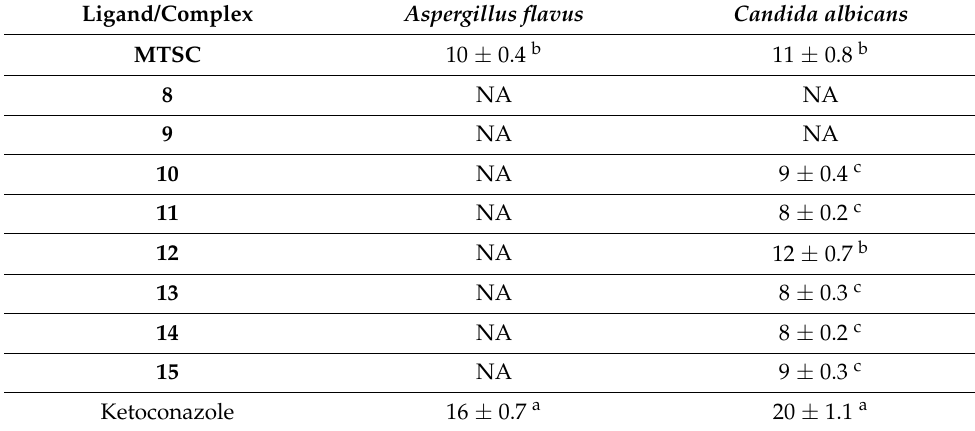
Table 6. Antifungal activities of MTSC ligand and its metal complexes (inhibition zone diameter) at a concentration of 1 µ M.